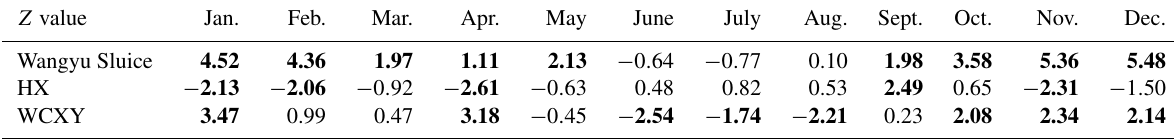
Table 4. Tendencies analysis of net water diversion and drainage amount along the Yangtze River. Z value Jan. Feb.